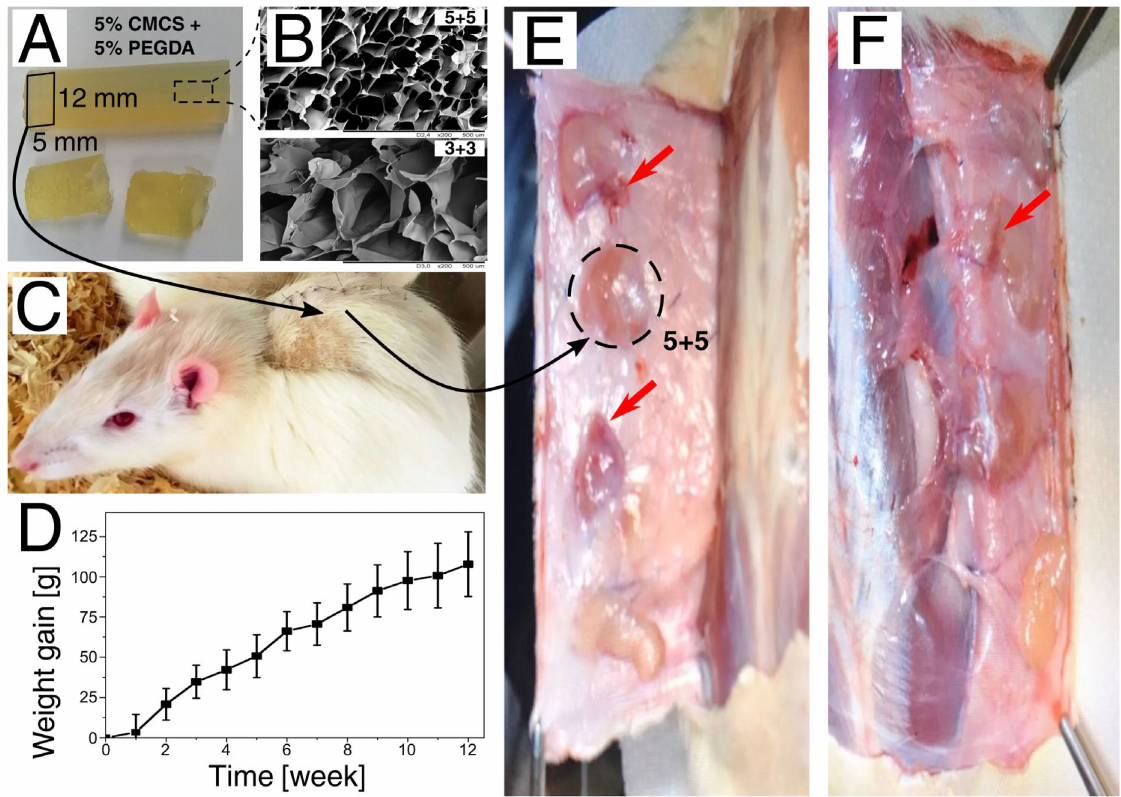
Figure 7. The outline of the biocompatibility test. ( A ) An exemplary hydrogel, i.e., 5% CMCS + 5% PEGDA formulation. ( B ) Images obtained by scanning electron microscopy; the upper one (5 + 5) corresponds to freeze-dried hydrogel from the first subfigure, while the bottom one highlights the microstructure differences visible in the 3% CMCS + 3% PEGDA (3 + 3) formulation. ( C ) Rat after subcutaneous implantation. ( D ) Weight gain of rats after the surgery. ( E , F ) Macroscopic evaluation of implantation sites (slight hyperemia is marked with red